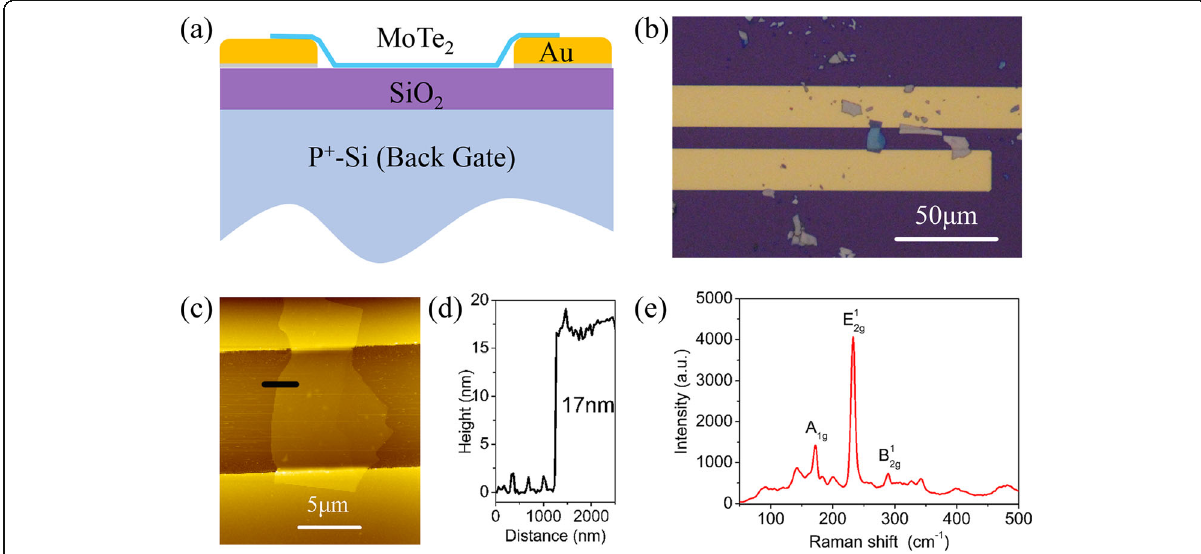
Fig. 1 Multi-layered MoTe 2 transistor and its properties. a Illustration of MoTe 2 transistor diagram. b Optical image of one of the fabricated transistors composed of multi-layered MoTe 2 channel and SD Cr/Au electrodes. c AFM image of the transistor channel in b . d Height profile of the multi-layered MoTe 2 . e Raman spectrum of the multi-layered MoTe 2 in the transistor